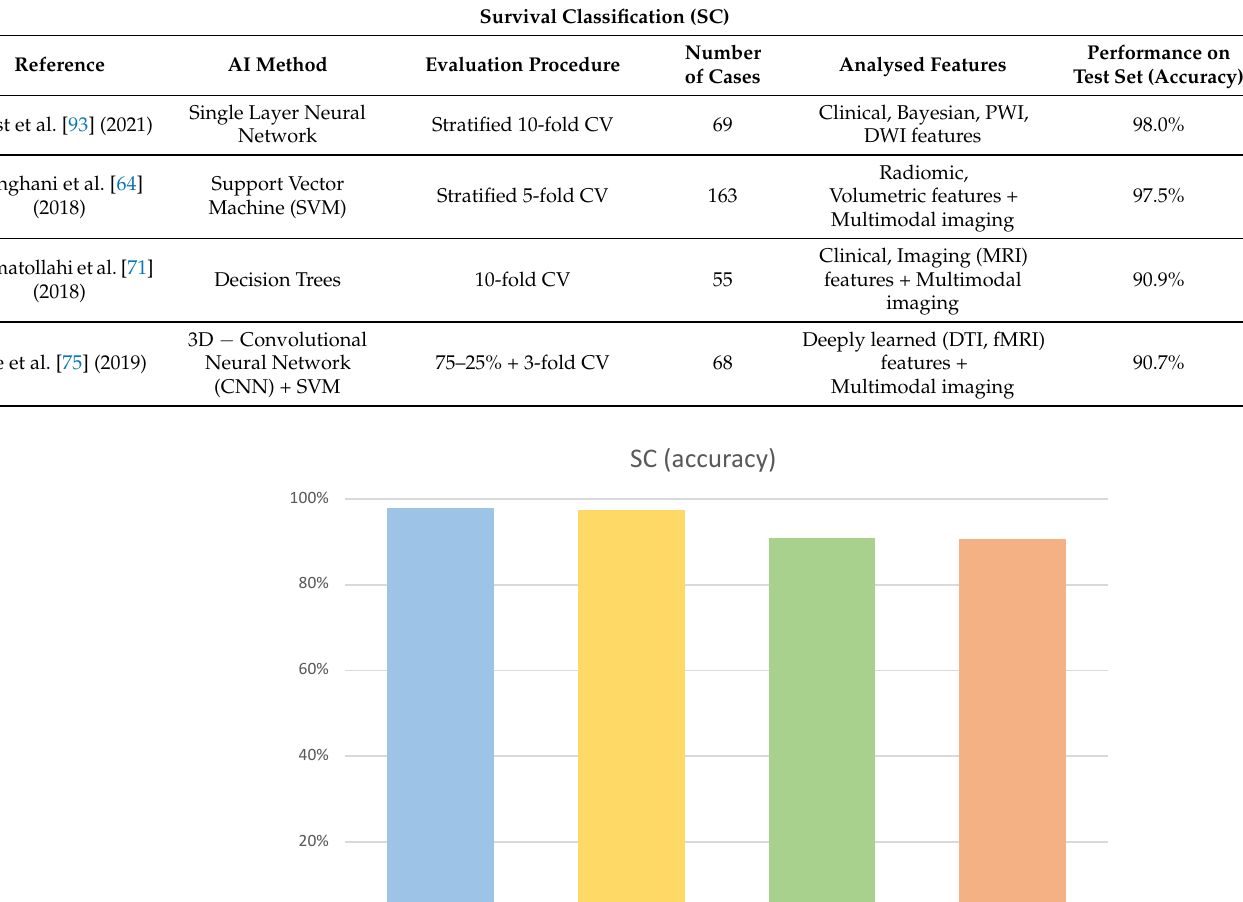
Figure 3. Performance of OS task: Graphical representation of the performance of the four best methods for the Overall Survival (OS) task, as evaluated by C-Index [68,87,89,90]. Table 2. Characteristics and performance (accuracy) of the four methods with the highest accuracy for Survival Classification (SC).